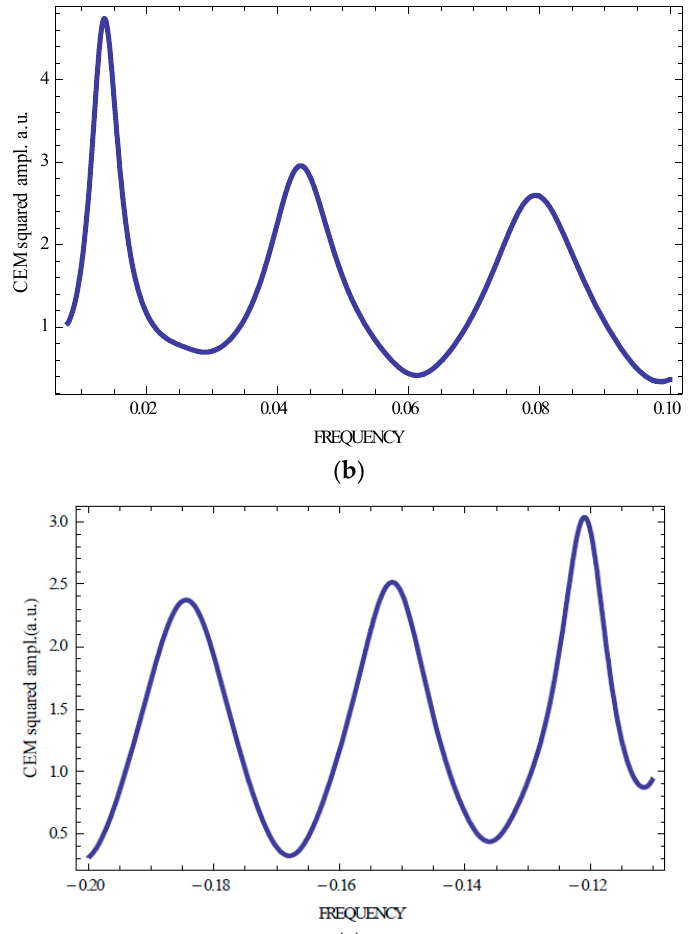
Figure 2. Calculated versus frequency reflection coefficient ( a ) for non-absorbing and isotropically absorbing CLC layer [ δ (1 + sin θ ) / 2 = 0.05, thickness in period number N = 100, γ = 0, 0.003, 0.006 (shown at decreasing line thickness)], and squared CEM amplitude for a non-absorbing CLC at the high frequency ( b ) and low frequency ( c ) stop band edge for three first CEMs (n = ± 1, ± 2, ± 3); here and at all figures below the dimensionless frequency ω d = δ (1 + sin θ )/2[2( ω − ω B )/ ω B δ (1 + sin θ )/2 − 1)], where ω B = c τ /2sin θε 01/2 is used (i.e. normalized by the Bragg frequency the difference of the frequency and the stop band edge frequency).